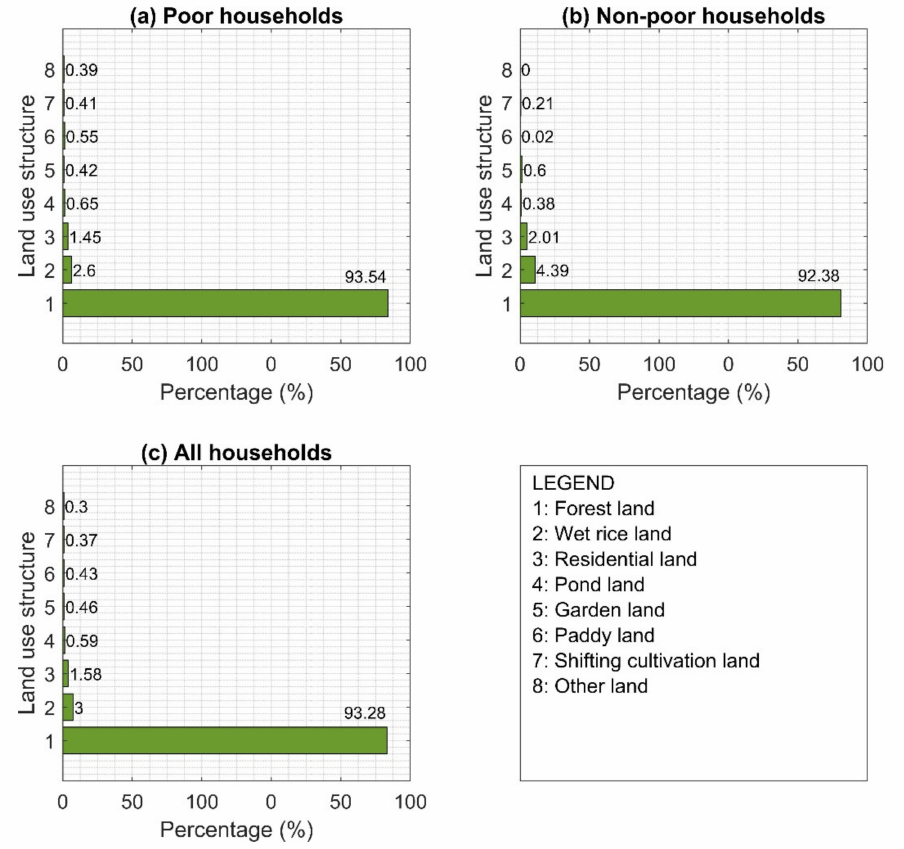
Figure 3. Forestland distribution by land types. Source